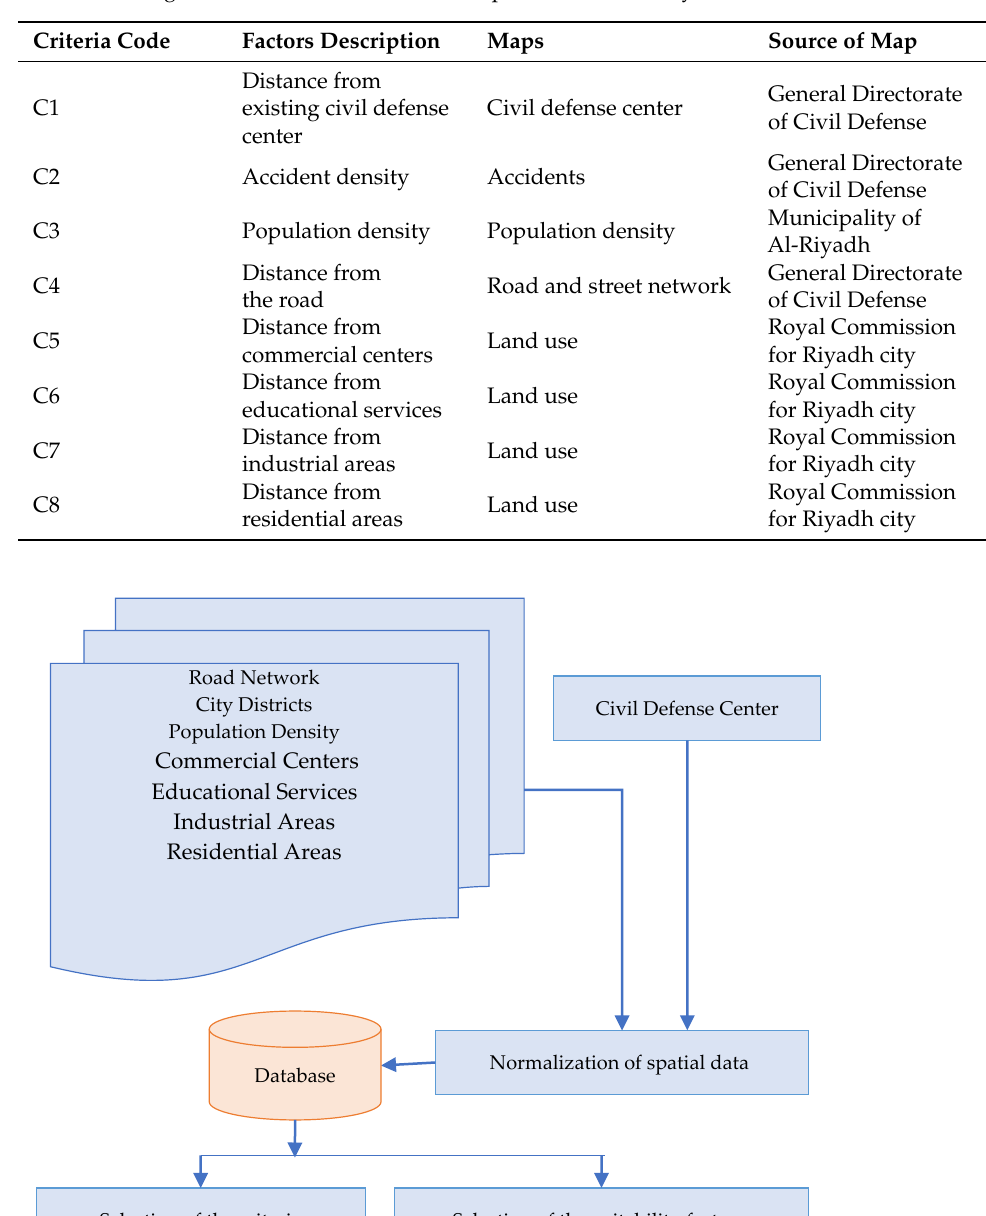
Table 2. Coding criteria and data sources of the prediction-factor layers.